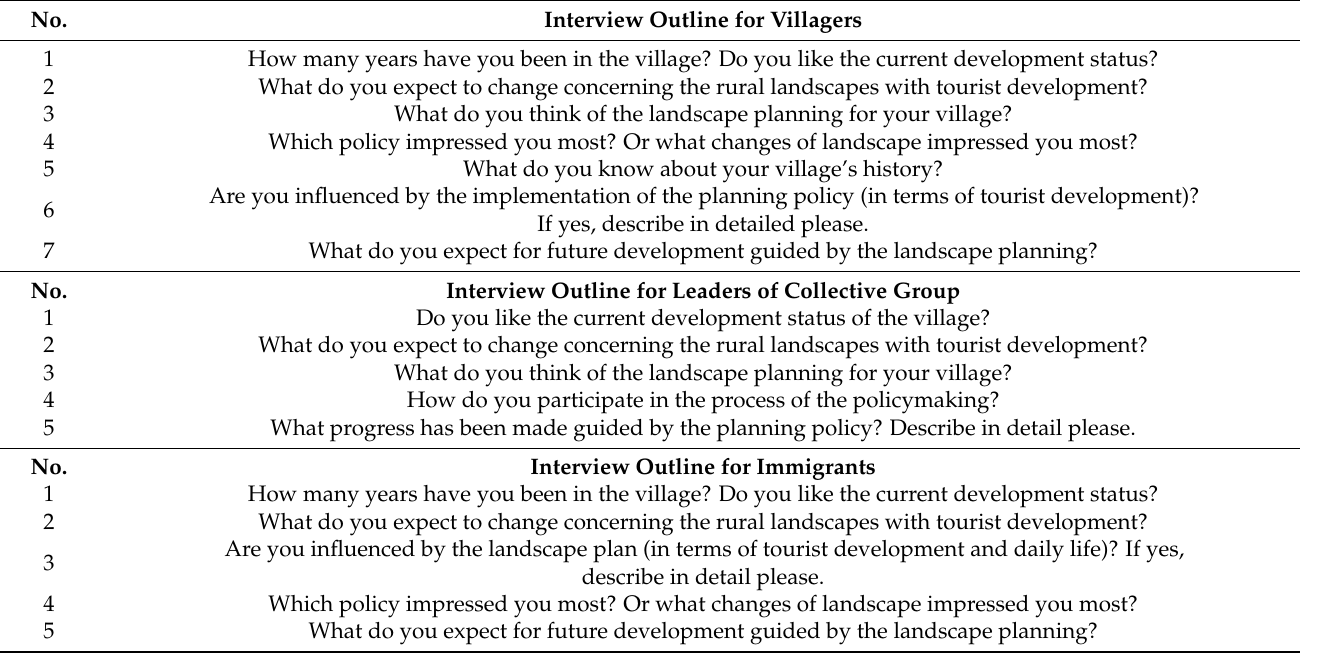
Table A1. Main interview